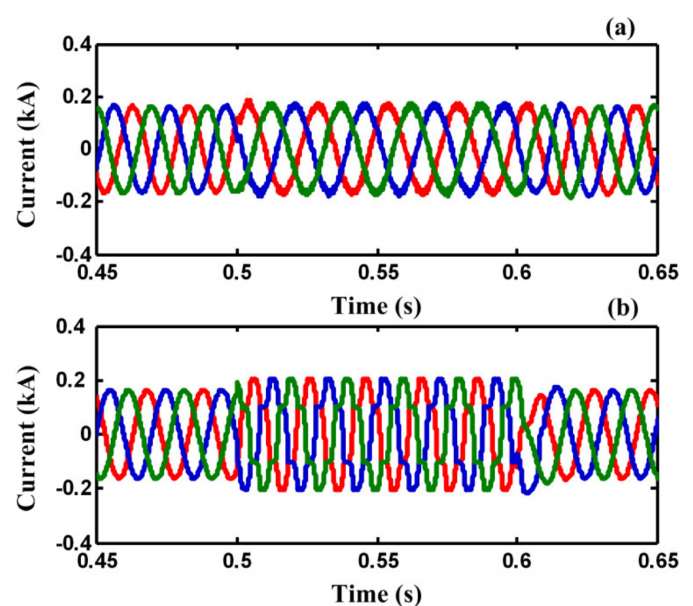
Figure 11. ( a ) The load current and, ( b ) fault current of faulted feeder (F2) during fault operation mode in case